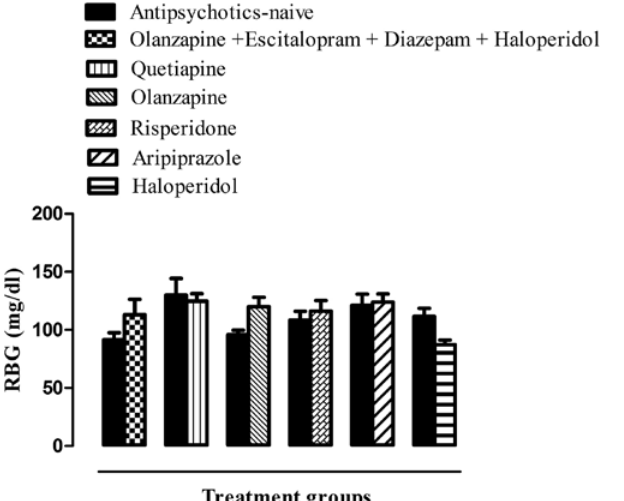
FIGURE 1 - Effect of selected antipsychotics on random blood glucose: Antipsychotic-naïve patients were put on olanzapine in combination with escitalopram, diazepam (STAT, I.V) and haloperidol (STAT, I.M) (OLEDH, n=8), quetiapine (QUET, n=8), olanzapine (OLAN, n=8), risperidone (RISP, n=8), aripiprazole (n=8) or haloperidol (n=8) in therapeutic doses for an average time period of 39, 40, 45, 38, 30 and 33 days respectively showing no significant change in random blood glucose as compared to antipsychotics-naïve patients (n=8) (ANOVA followed by Bonferroni’s Multiple Comparison Test) (P > 0.05). TABLE I - Per cent wise distribution of patients with disturbed ( ≥ 140 mg/dl) glucose before and after exposure to antipsychotic